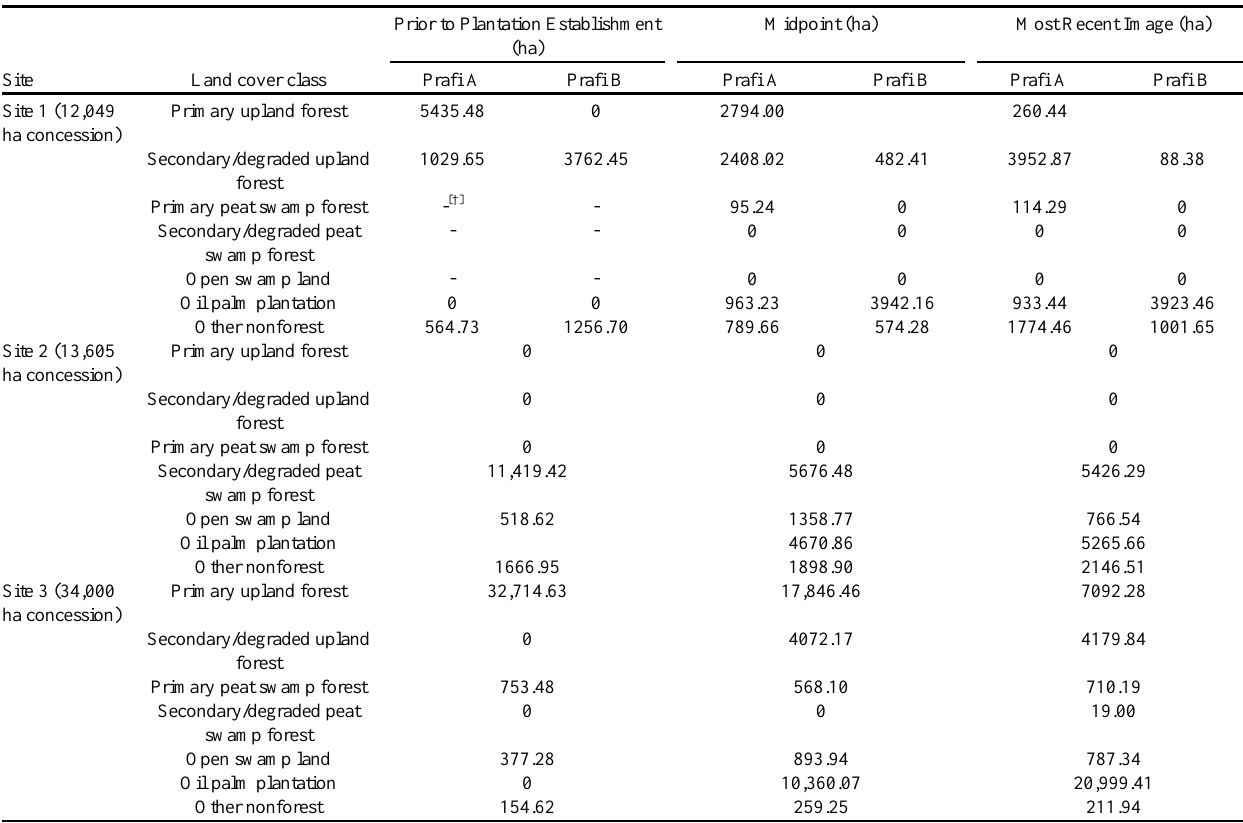
Table 6 . Land cover change in all sites